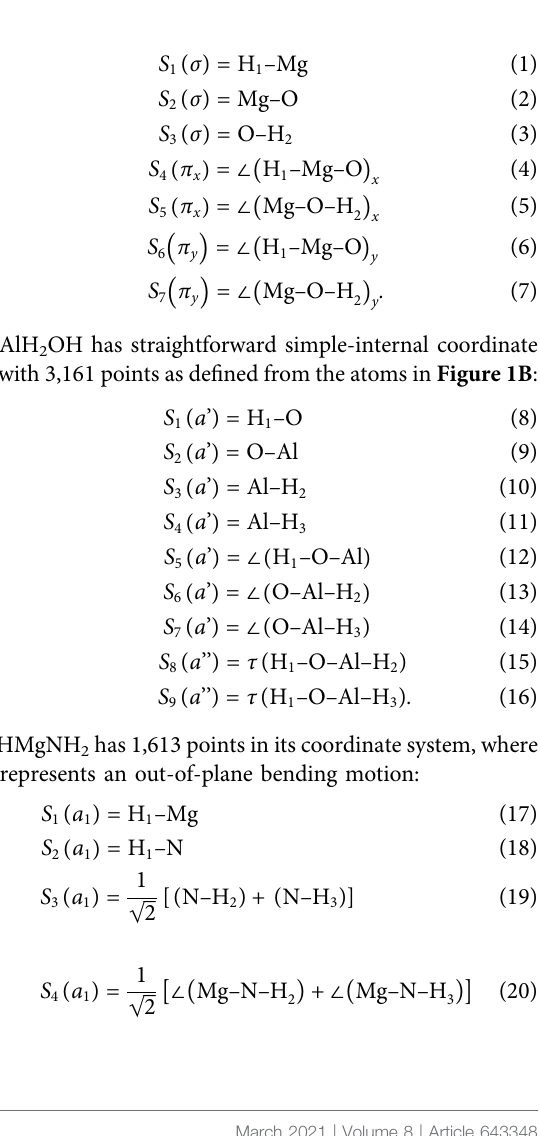
FIGURE1 | The Optimized Structures of (A) HMgOH, (B) AlH 2 OH, (C) AlH 2 NH 2 , and (D) HMgNH 2 with Hatomsin white, O in red,N in blue, Mg in green, and Al in gray.